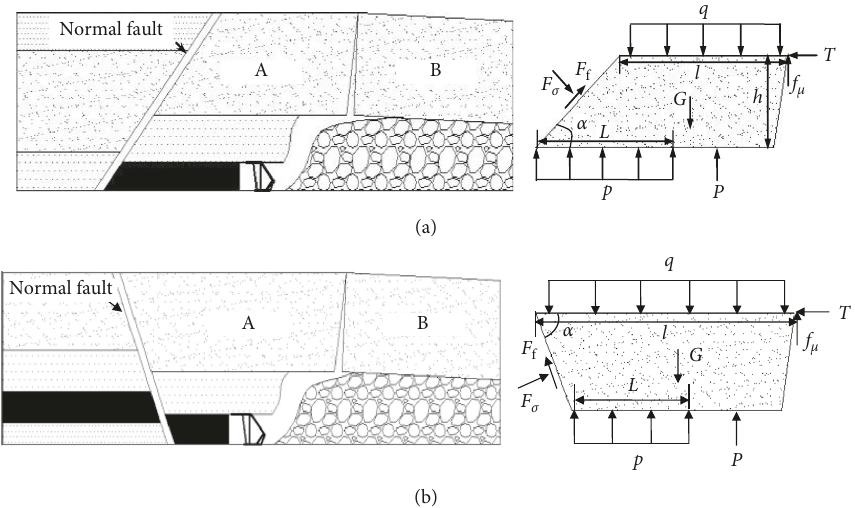
Figure 9: Mechanical analysis of roof rock near fault with different mining directions. (a) Footwall mining. (b) Hanging wall